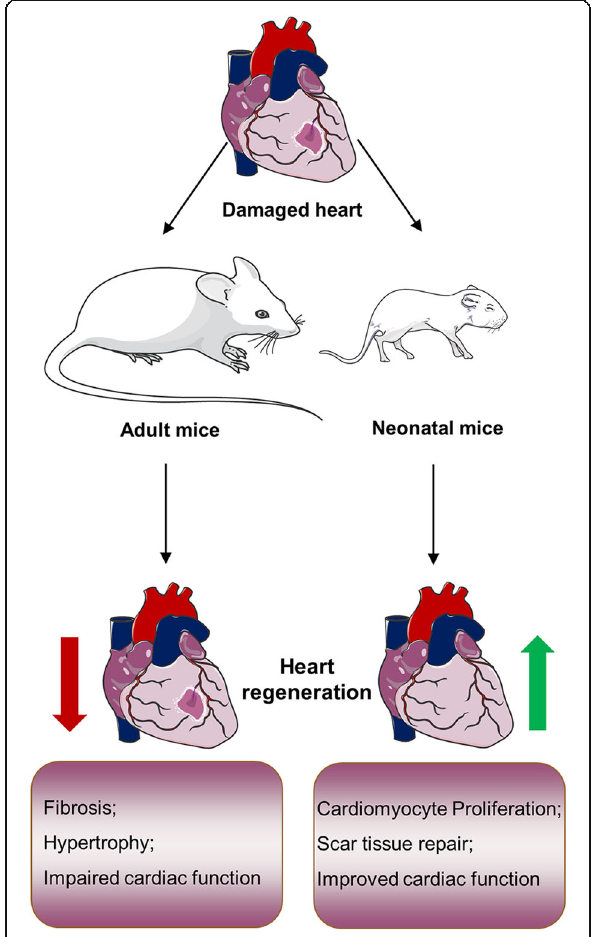
Fig. 1 Overview of heart regeneration in mice inside and outside the regeneration window. After cardiac damage, neonatal mice exhibit promotion of cardiomyocyte proliferation, scar tissue repair, and improvement in cardiac function. Conversely, adult mice exhibit myocardial fibrosis, hypertrophy, and impairment of cardiac